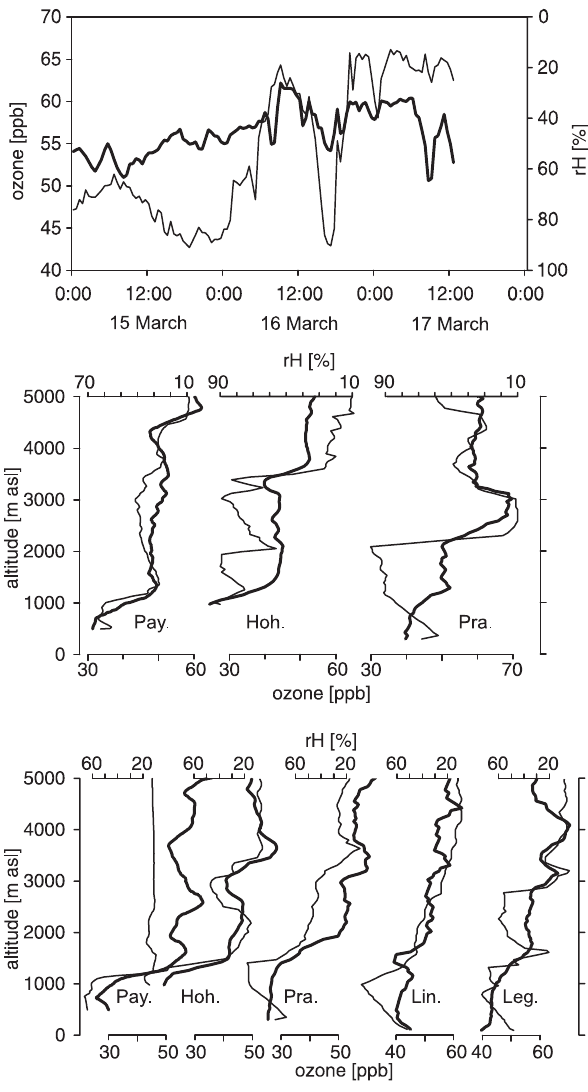
Fig. 14. Measurements of ozone concentration (thick lines) and rel- ative humidity (thin lines) at Zugspitze from 15 to 17 March 1999 (top). The centre and lower panels show ozone and humidity pro- files for 15 March, 12 UTC, and 17 March, 12 UTC from different locations in Europe (indicated in Fig. 12). Note that the scale for relative humidity is inverted in all panels.